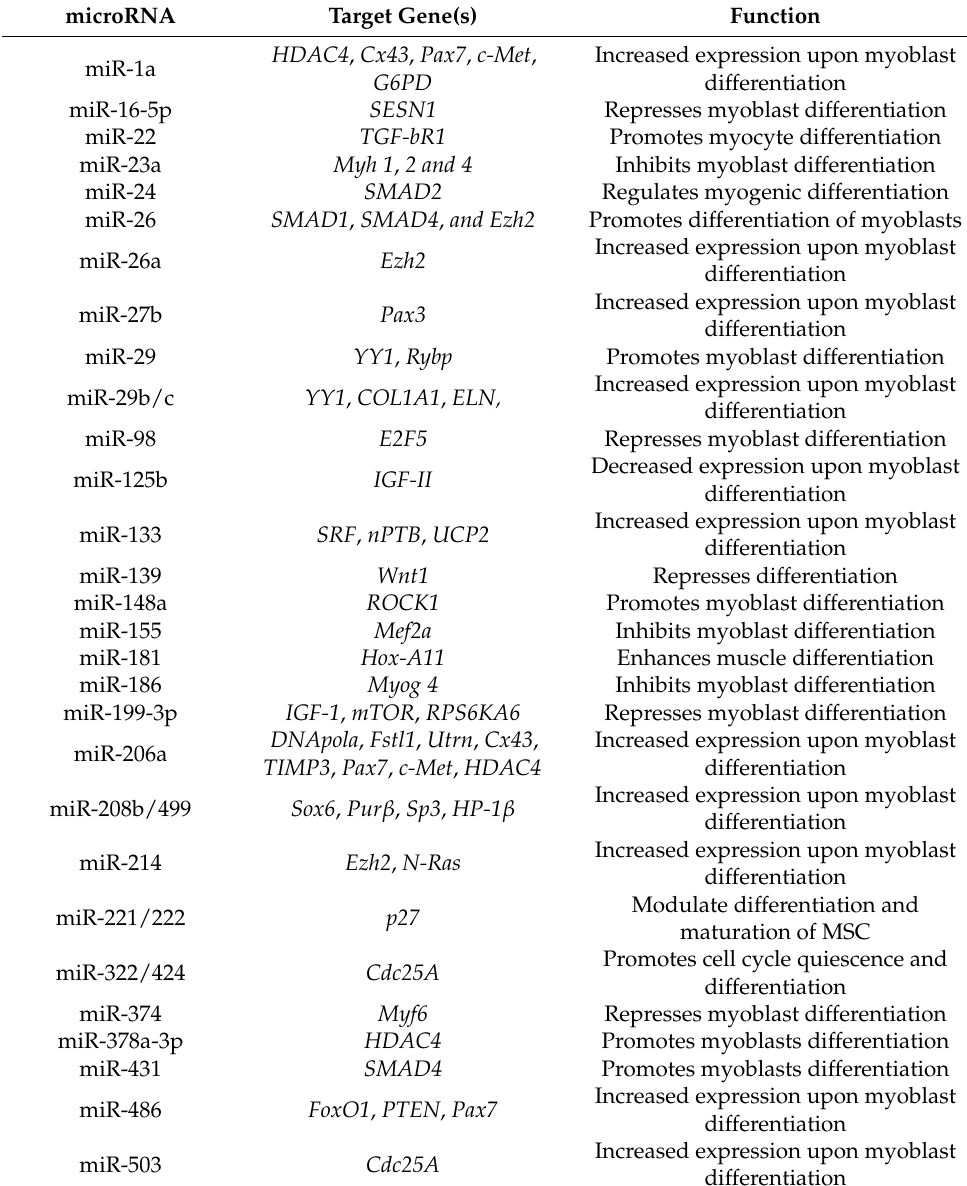
Table 2. miRNA involved in the regulation of myoblast